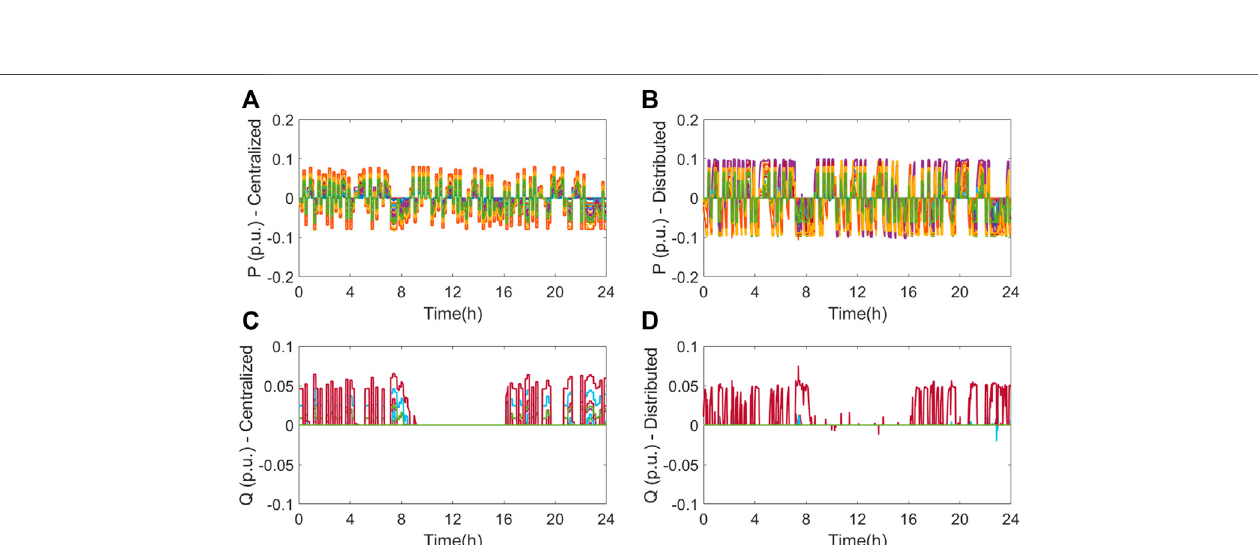
FIGURE 7 | Case III: comparative results of VSP dispatch using a centralized optimization and the proposed distributed control: (A,B) active power outputs of individual storage devices; and (C,D) reactive power outputs of individual storage devices.